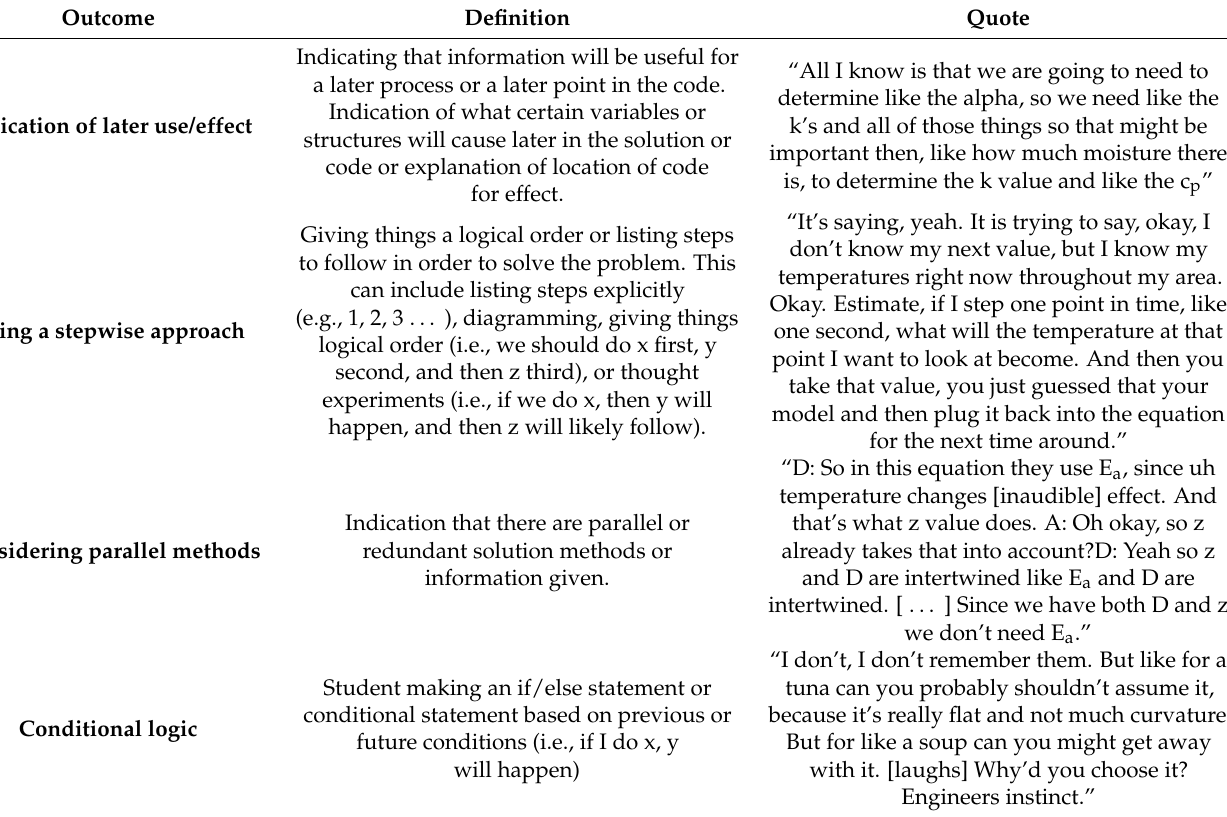
Table 5. Definitions and quotes of CT outcomes identified for algorithmic thinking (letters denote individual deidentified